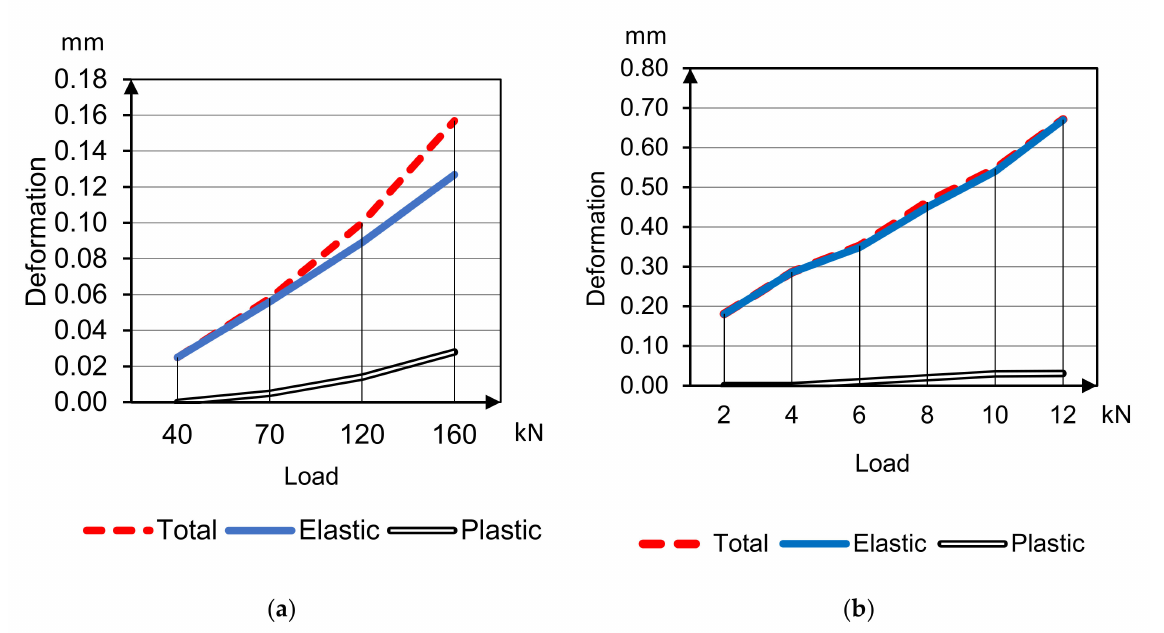
Figure 6. Deformation and deflection curves for concrete 1 under compression ( a ) and bending ( b ) tensile.